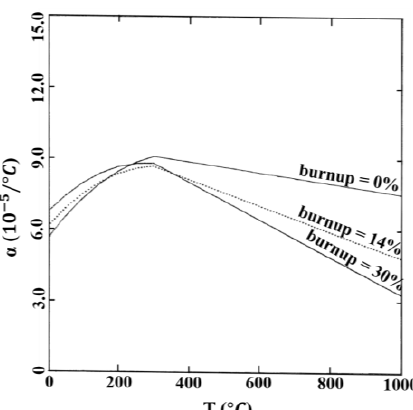
Figure 1: Temperature reactivity coefficient of fuel (absolute value) depending on the temperature and burnup of fuel for standard fuel element (12 w/o) in TRIGA reactor [8]